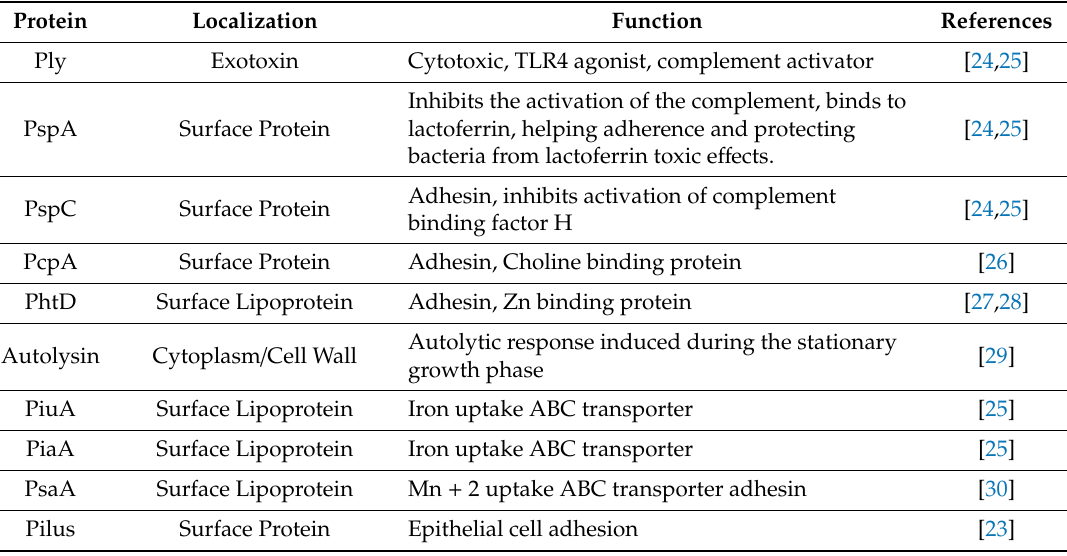
Table 1. Main proteins that contribute to the virulence of pneumococcus and their functions. Protein